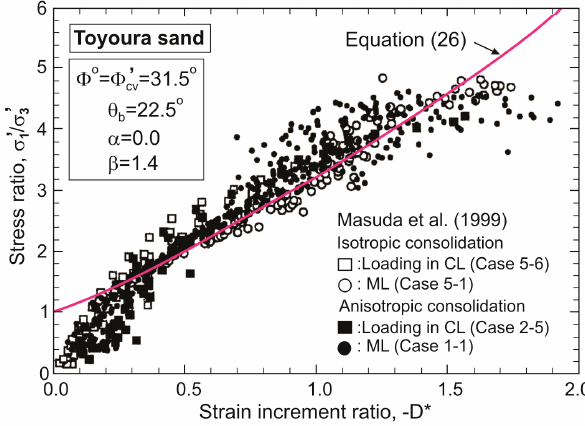
Fig. 8. Relationship between the stress ratio and the strain increment ratio for biaxial loading tests on Toyoura